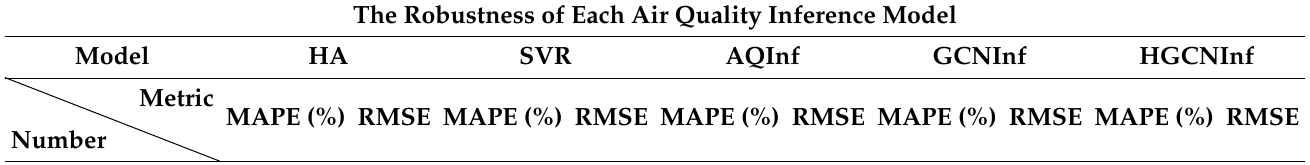
Table 3. The robustness comparison of inference models.